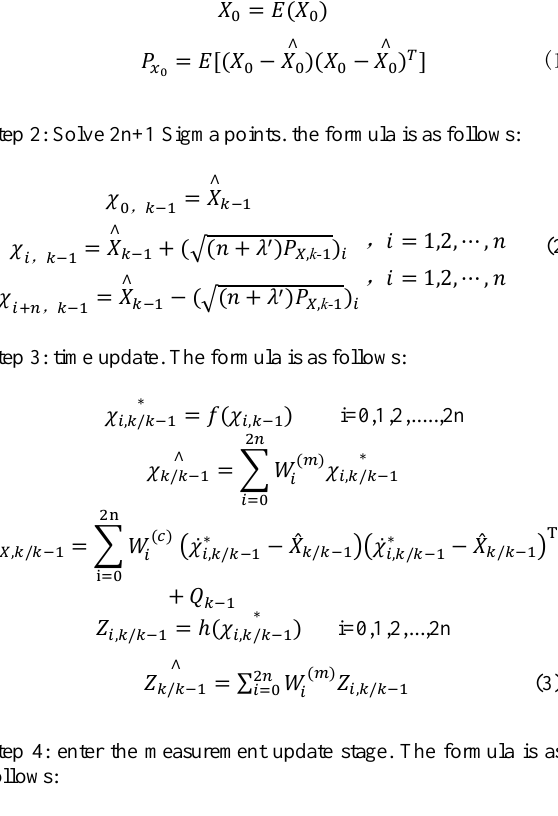
Figure 2 . BP neural network structure